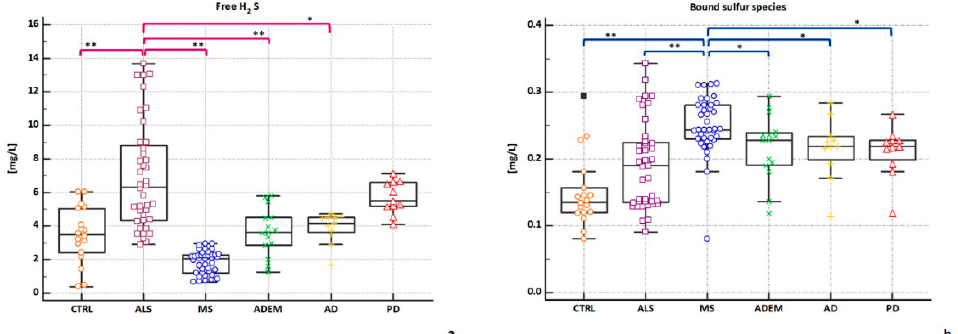
Figure 3. Comparison of free H 2 S and bound sulfur levels in all clinical groups analyzed. Data were analyzed with the Mann–Whitney test. Panel ( a ) shows free H 2 S measurements in all the clinical groups analyzed. Significant differences in free H 2 S levels have been highlighted between ALS group (purple), and the other groups (* p < 0.05, ** p < 0.0001). Panel ( b ) shows bound sulfur measurements in all the clinical groups analyzed. Significant differences in bound sulfur levels have been highlighted between MS group (blue), and the other groups (* p < 0.05, ** p < 0.0001). CTRL = control; ALS = Amyotrophic lateral sclerosis; ADEM = Acute Disseminated Encephalomyelitis; AD = Alzheimer’s disease; PD = Parkinson’s disease; MS = Multiple Sclerosis. Pearson’s analytical test has been applied by comparing bound sulfur and free H 2 S for each group analyzed. No correlation between the two variables was found for CTRL